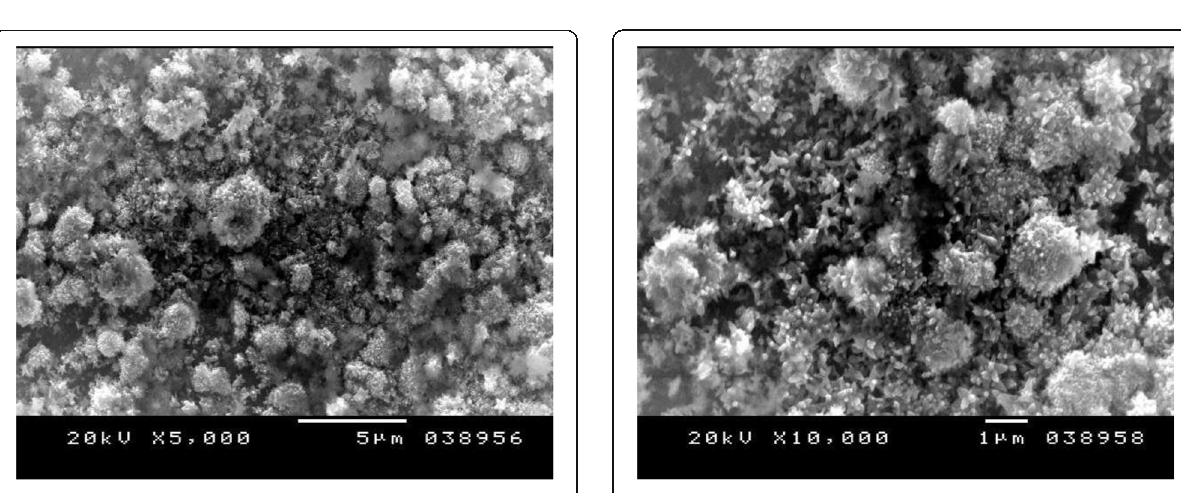
Fig. 4 Scanning electron microphotograph of Cp titanium specimen coated with nano HA- Zn at ×5000